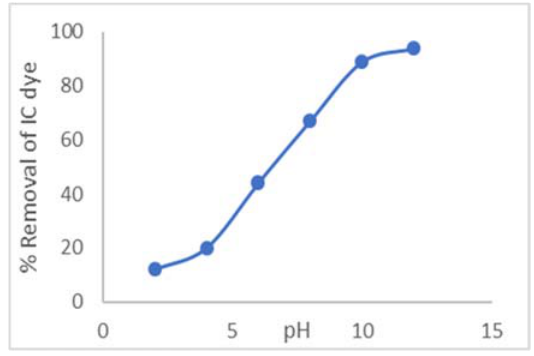
Fig. 9. Effect of pH on the removal of IC dye at 30 o C, 4 days contact time, 10 ppm dye concentration and 0.25 gm adsorbent dosage